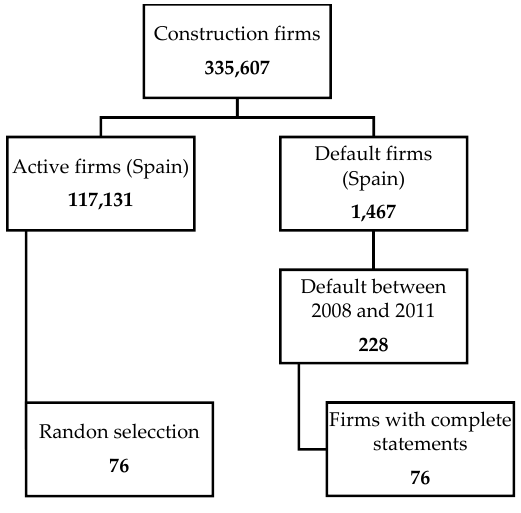
Figure 1. Summary of samples.